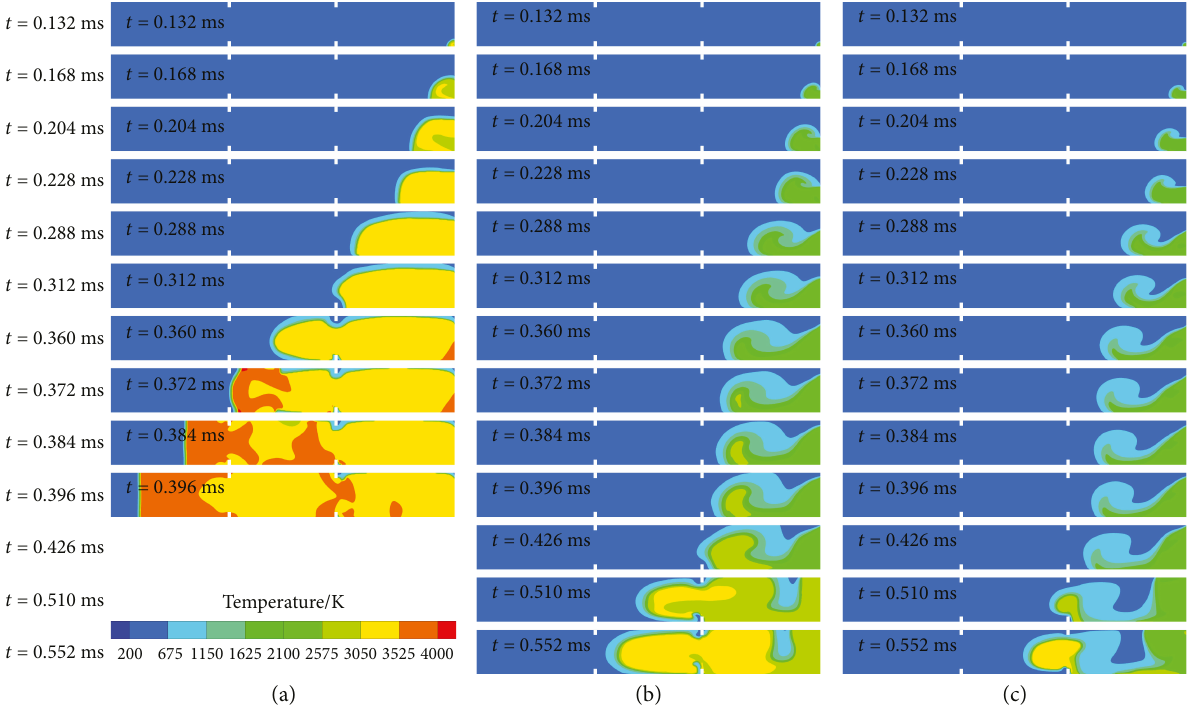
Figure 15: Simulated temperature cloud charts in WRC channel 2 when hot-jets of di ff erent species are used: (a) combustion products, (b) , and (c) Ar N 2 2